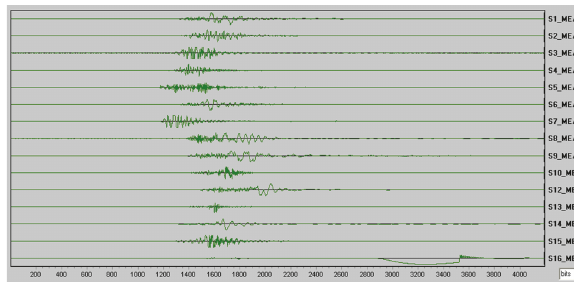
Figure 9: Waveforms of the destructive mining MS